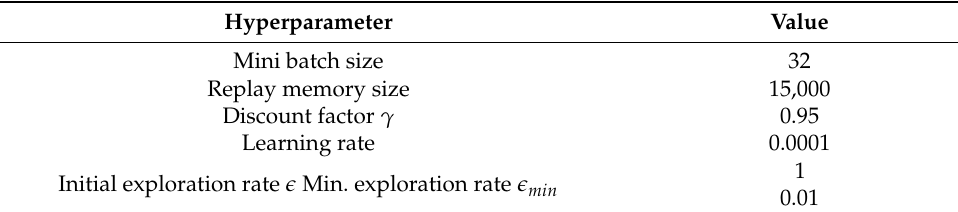
Table 5. The layer structure of D3QN. The selected hyperparameters for D3QN.